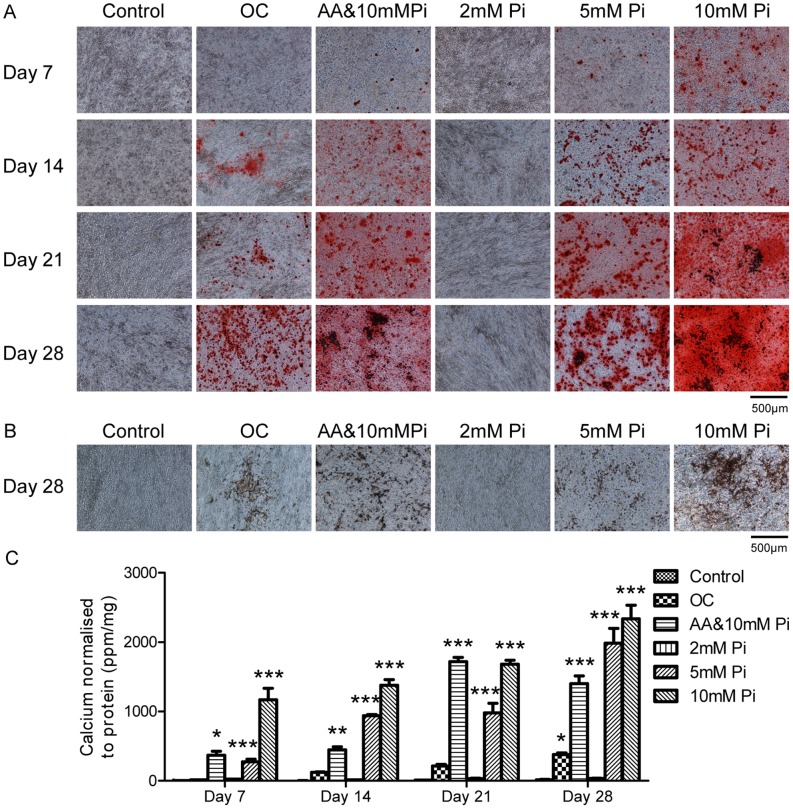
Investigating the effect of increasing concentrations of inorganic phosphate on 4T1 cell mineralization.Representative images were captured at 100× magnification and the scale bars represent 500 µm. (A) Positive alizarin red S staining for calcium (red) was observed in the OC treated group by day 14 and on day 7 for the AA&10 mM Pi, 5 mM Pi and 10 mM Pi treated groups. (B) Positive von Kossa staining for calcium phosphate (black/brown) was observed in the OC, AA&10 mM Pi, 5 mM Pi and 10 mM Pi on day 28. (C) The calcium content of 4T1 cells as determined by the o-cresolphthalein calcium assay normalized to protein. Increases in calcium were observed in the OC, AA&10 mM Pi, 5 mM Pi and 10 mM Pi groups over time, with the greatest increase detected in the 10 mM Pi group. Each point represents the mean amount of calcium measured in ppm normalized to protein measured in mg, +/− SEM, n = 3, two-way ANOVA. *P<0.05, **P<0.01, ***P<0.001 vs. control at each time point. OC (osteogenic cocktail) = 50 µg/ml ascorbic acid and 10 mM β-glycerophosphate. AA = 50 µg/ml ascorbic acid. Pi = inorganic phosphate.